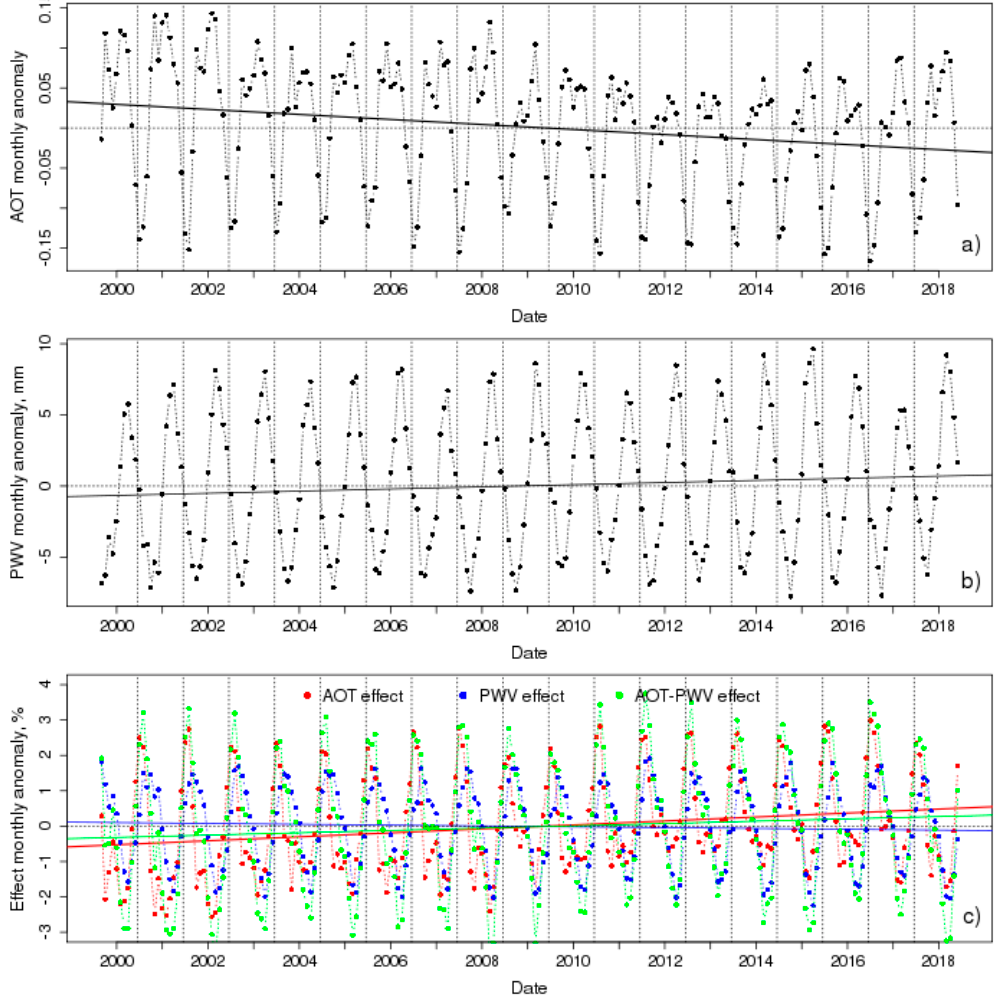
Figure 7. Evolution of monthly mean values of (a) AOT, (b) PWV, (c) AOT effect, PWV effect and AOT-PWV effect anomalies, for the Mediterranean basin, from March 2000 to December 2018. Straight lines are the linear fits for the monthly data.